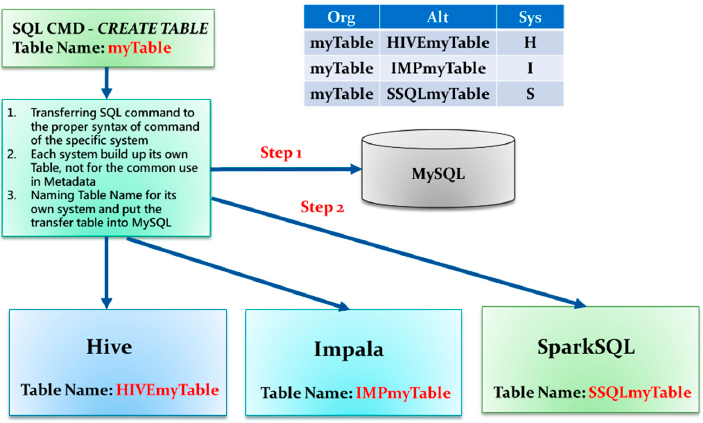
Figure 5. SQL query command to the tools.